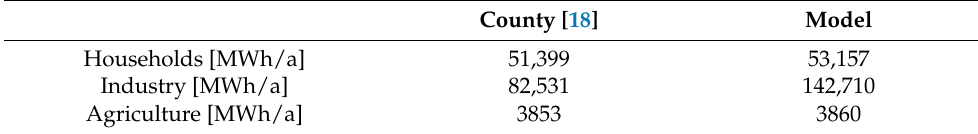
Table 2. Exemplary valdiation of load profile